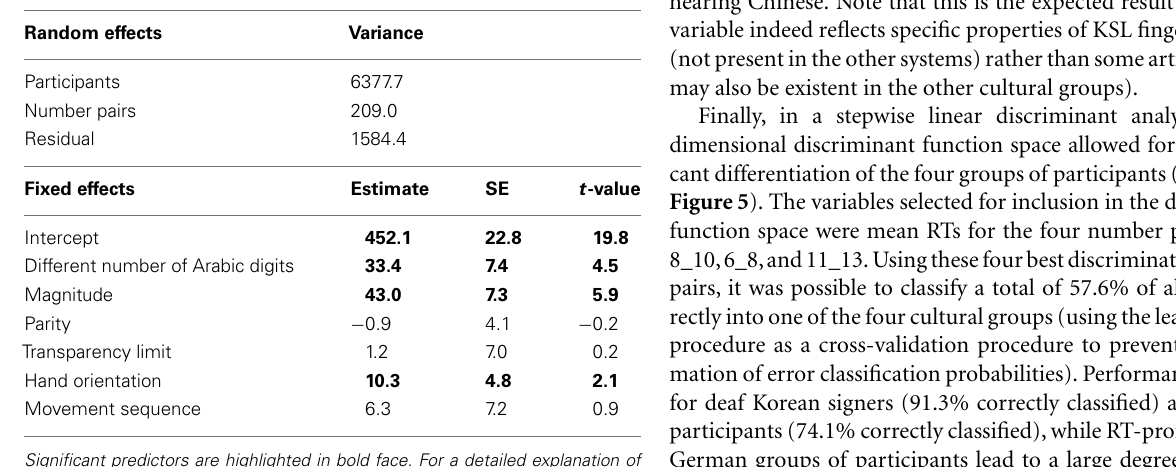
Frontiers in Psychology |